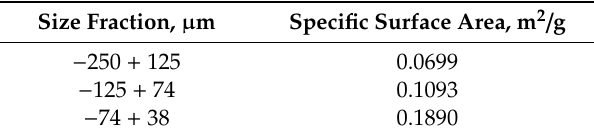
Table 2. Surface area of glass microspheres.